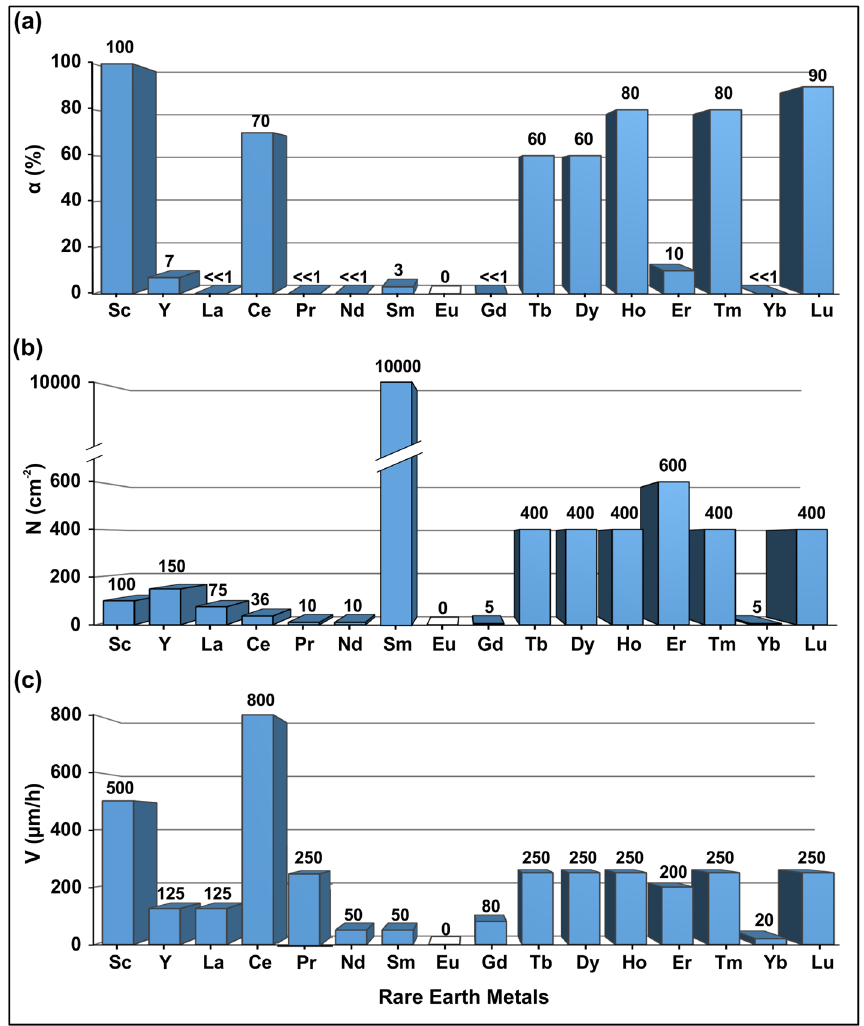
Figure 3. The results of diamond crystallization in REM-C systems at 7.8 GPa and 2000 °C. ( a ) Degree of graphite-to-diamond conversion; ( b ) density of diamond nucleation sites at the graphite–metal interface; ( c ) average linear diamond growth